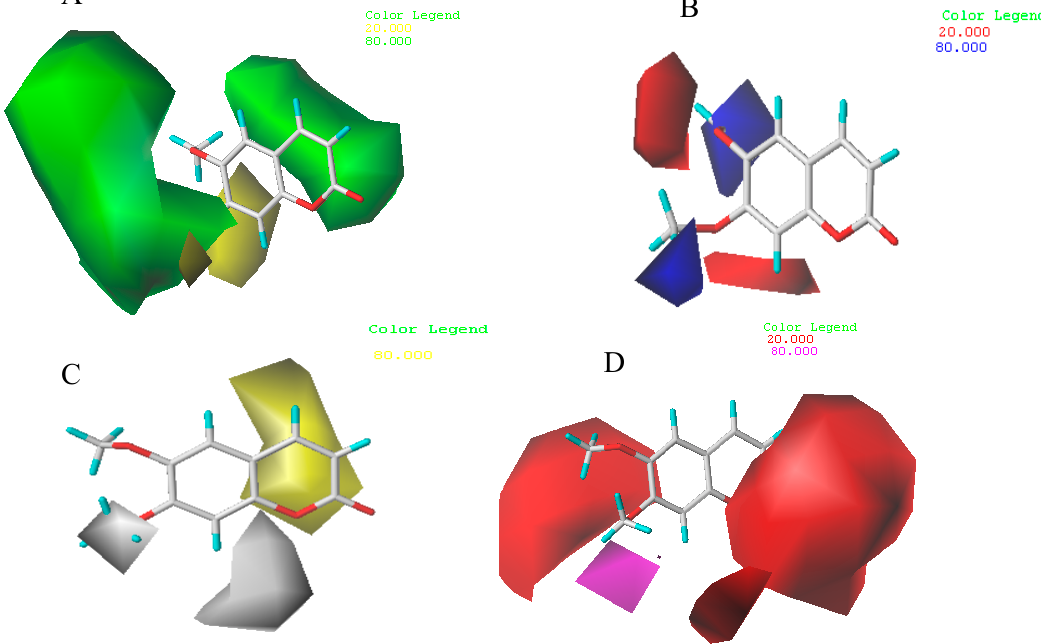
Figure 6. CoMSIA STDEV*COEFF contour maps around the compound 8 . ( A ) Steric fields: green contours and yellow contours show regions where an increase in bulky groups will increase and decrease activity, respectively; ( B ) electrostatic fields: blue contours and red contours show regions where an increase in electron positive groups and electron negative groups will increase activity, respectively; ( C ) hydrophobic fields: yellow contours and white contours show regions where an increase in lipophilicity and hydrophilicity will increase activity, respectively; ( D ) H-bond acceptor contour map: magenta contour and red contour show regions where an increase in hydrogen-bond acceptor groups and hydrogen-bond donor groups will increase activity.